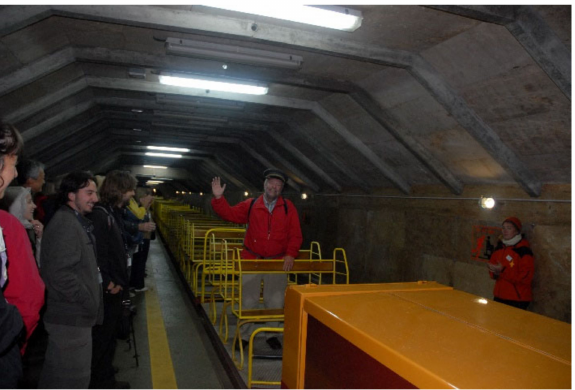
Figure 3. As a unique tourist attraction, Postojnska jama takes tourists to deep parts of the cave with the underground railway. Photo: Slavko